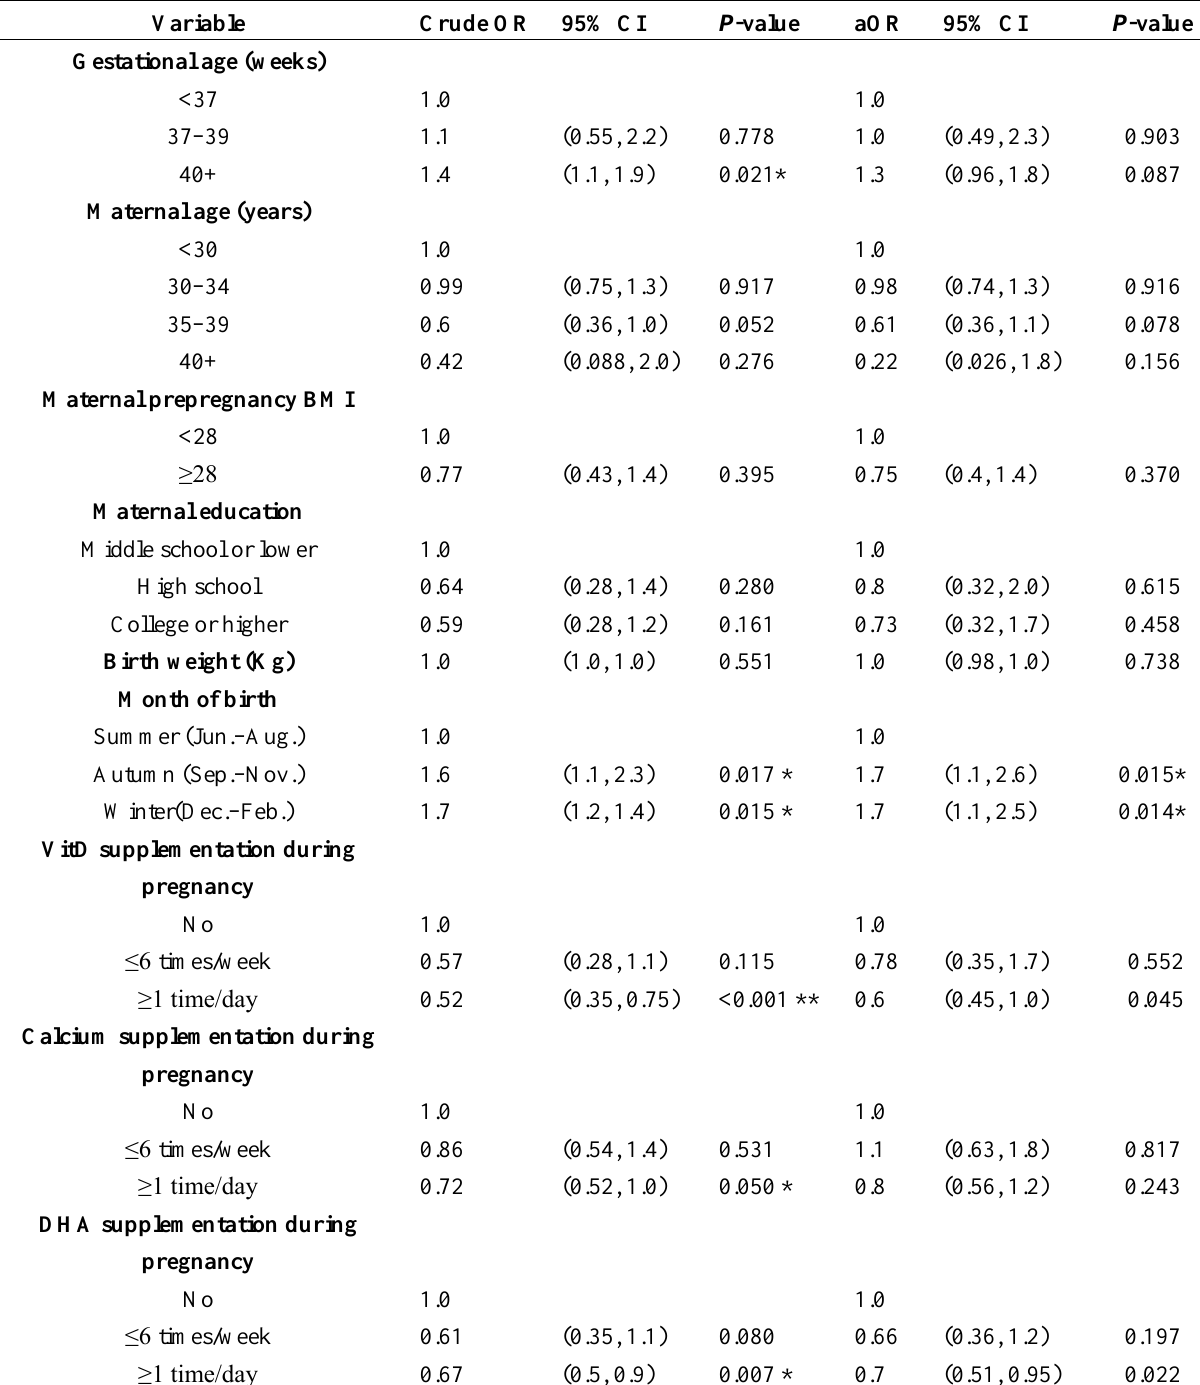
Table 3. Factors associated with cord serum 25(OH)D < 20 ng/mL by multivariable analysis ( n =